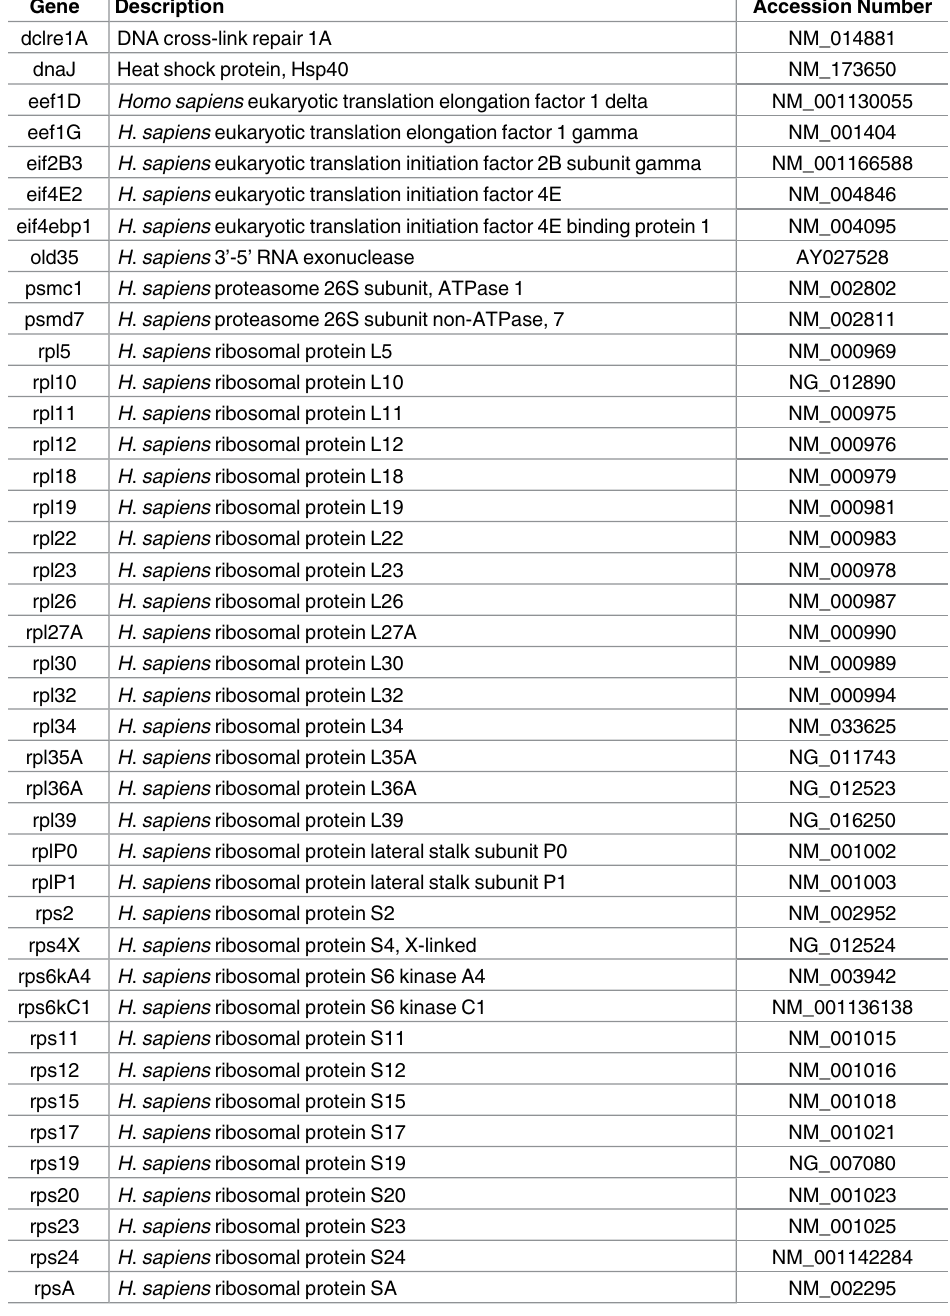
Table 1. Highly-expressed human gene set used in codon usage